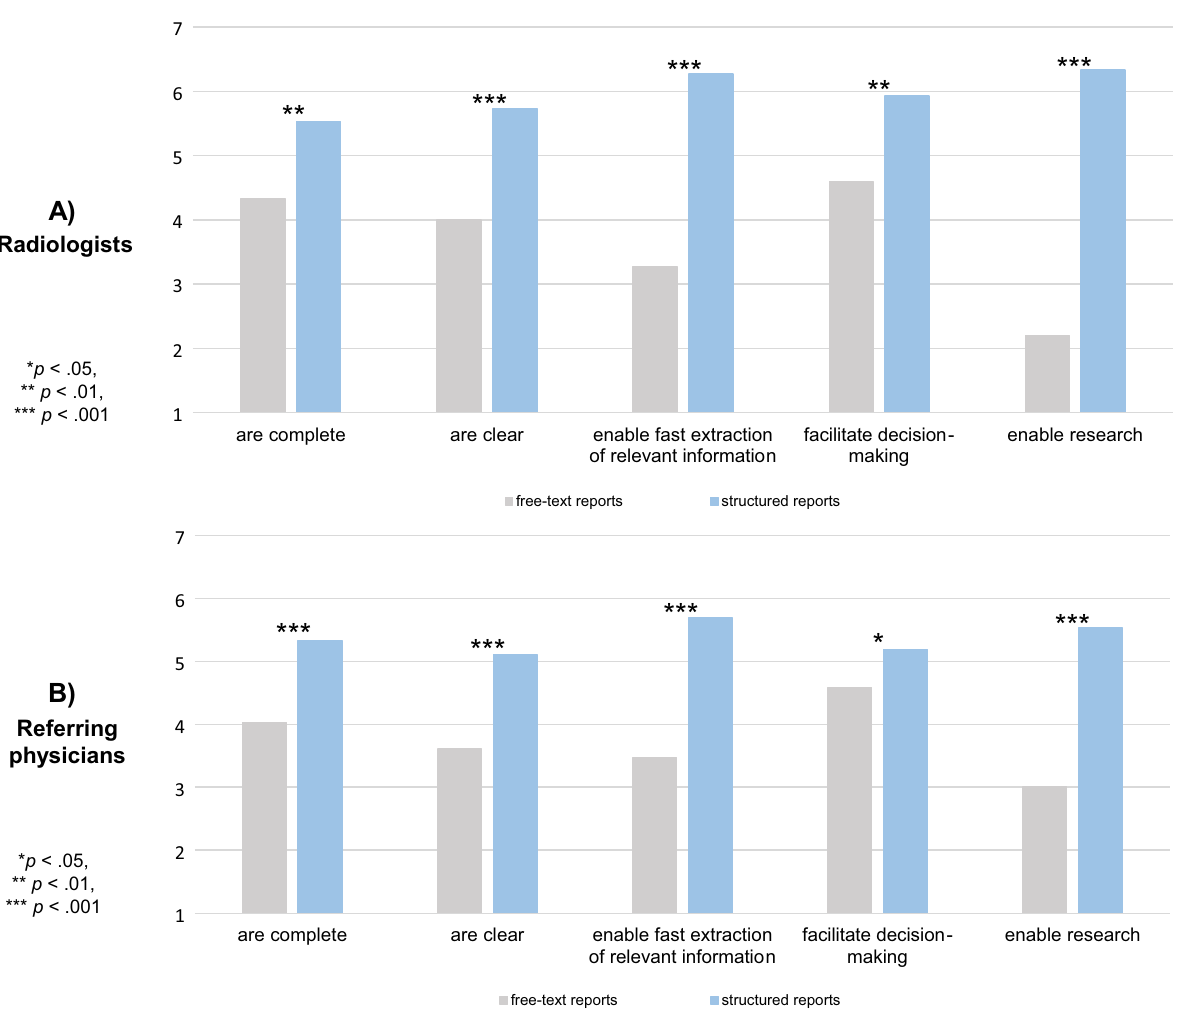
Fig. 5 Subjective evaluation of structured reports and free-text reports by radiologists ( A ) and referring physicians ( B ) on a 7-point scale. Grey bars represent free-text reports and blue bars structured reports